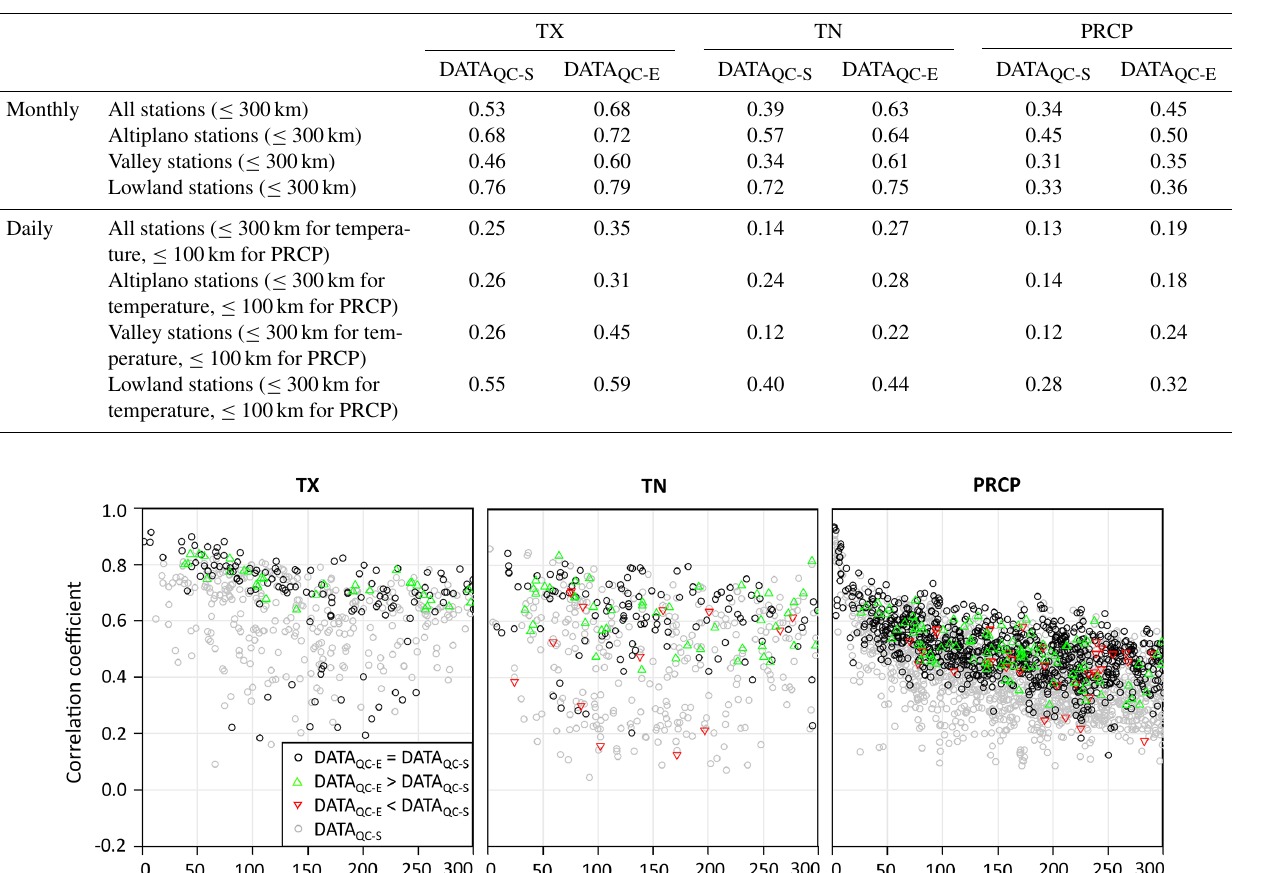
Table 3. Monthly and daily median correlation coefficients of station pairs within a 300km radius (100km for daily PRCP) for maximum temperature (TX), minimum temperature (TN), and precipitation (PRCP).